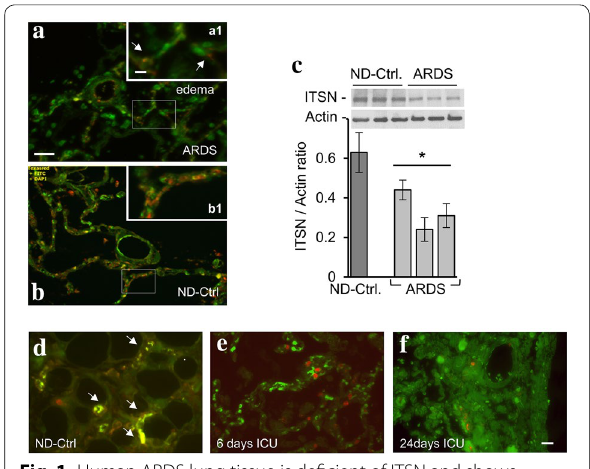
Fig. 1 Human ARDS lung tissue is deficient of ITSN and shows limited EC proliferation. a , b Representative ITSN-Alexa Fluor 594/ CD31-Alexa Fluor 488 IHC of lung sections of ARDS and ND-Ctrl specimens, respectively; insets are higher magnifications of boxed areas. The arrowheads in a indicate a lung vessel with perivascular edema. Arrows in a , inset indicate the limited co-localization ITSN/ CD31. Bars: 60 μm ( a , b ); 100 μm (insets). c Total protein extracted from ND-Ctrl and ARDS frozen lung tissues was analyzed by SDS PAGE (50 μg/lane) and WB with ITSN Ab. Actin served as loading control. The graph in c shows the average of ITSN/Actin ratio as determined by densitometric analyses of representative